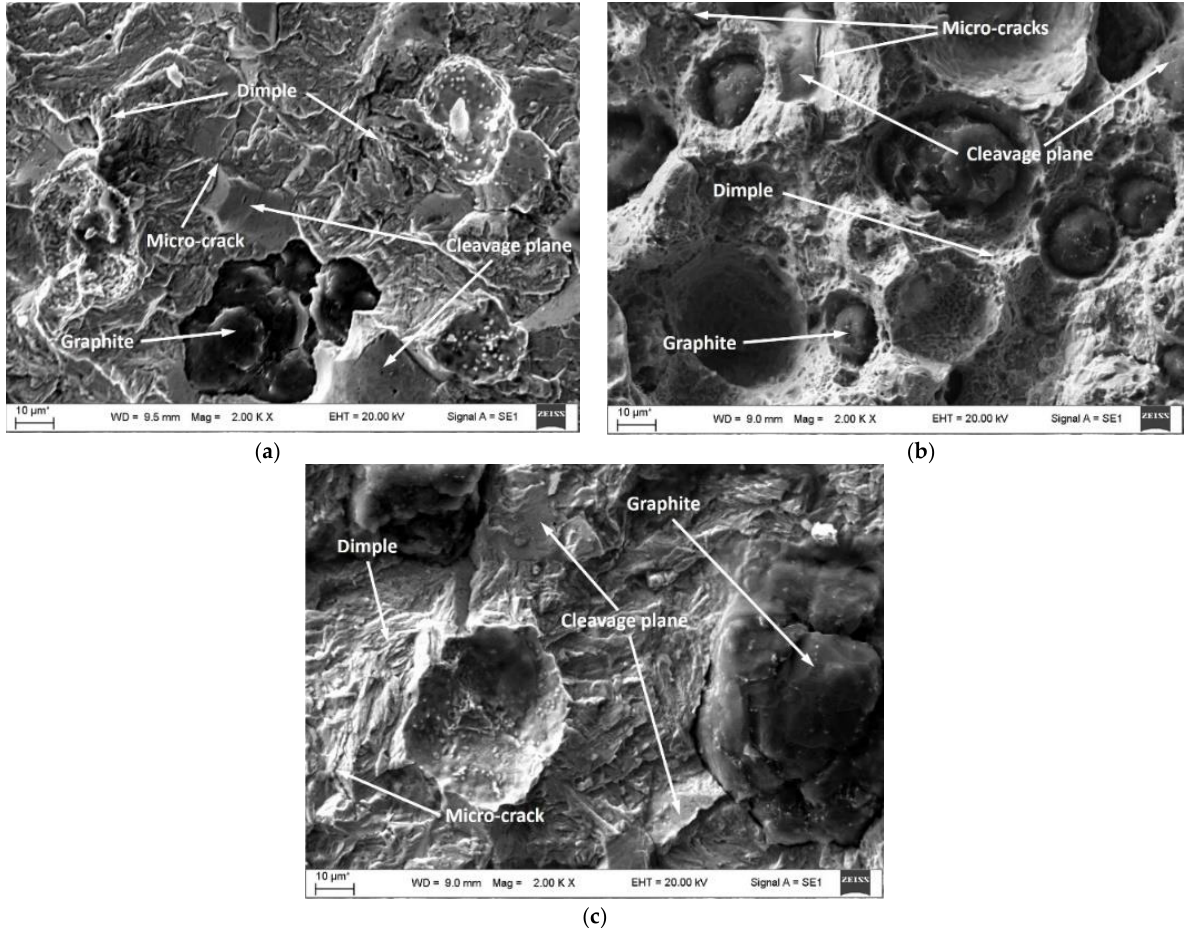
Figure 9. The fatigue fracture surfaces of ADI samples austempered at different temperatures: ( a ) 270 °C, ( b ) 300 °C, ( c ) and 330 °C, showing dimples, cleavage planes, micro-cracks, and graphite nodules.